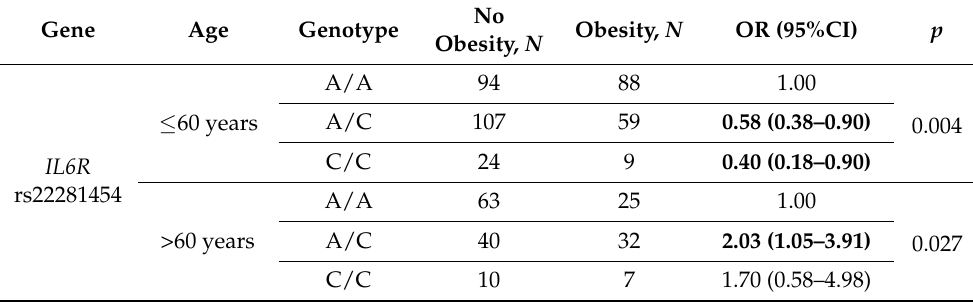
Table 5. Association of SNPs with obesity risk in groups stratified by